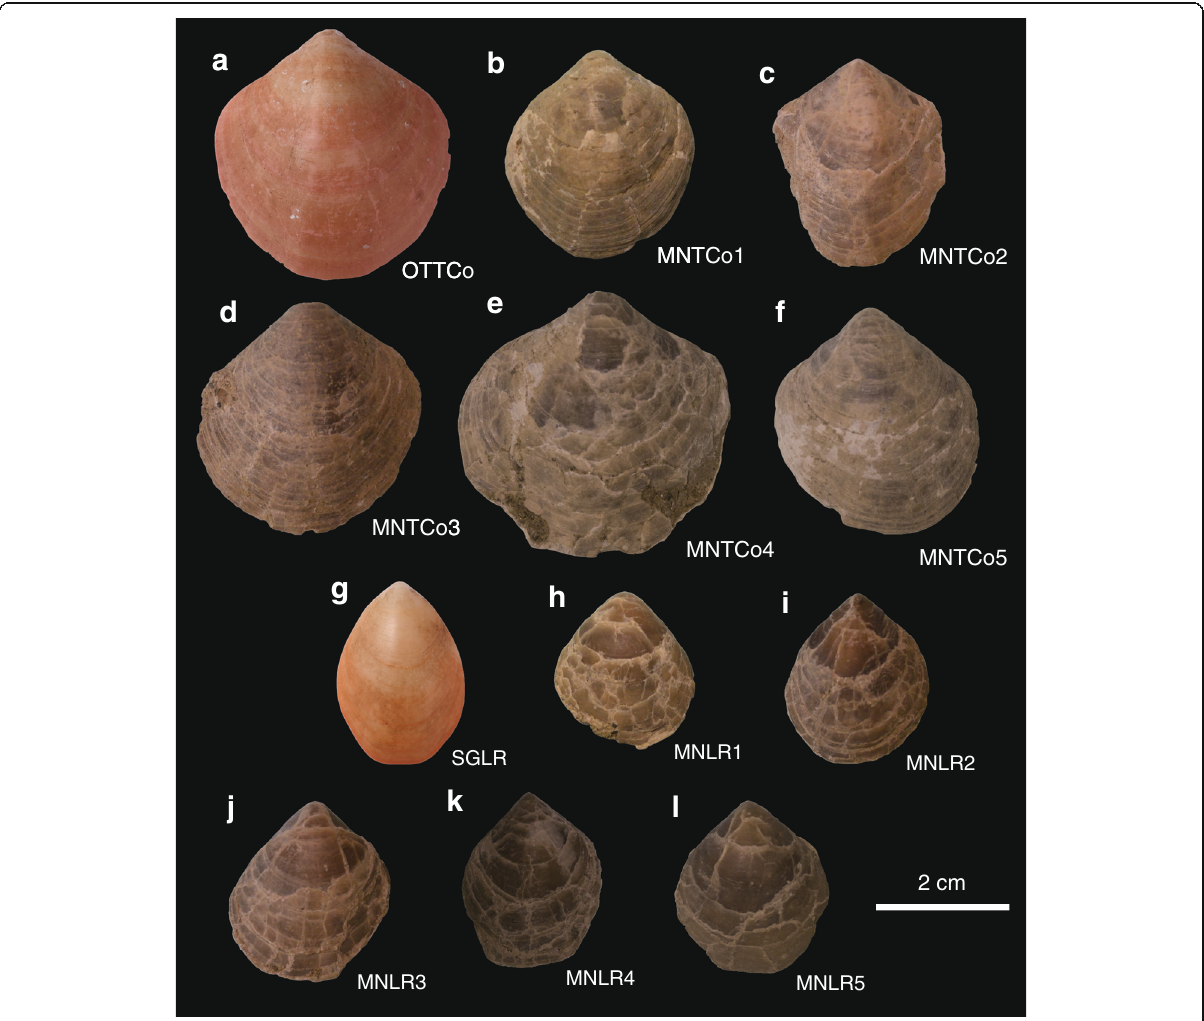
Fig. 1 Photographs of the Terebratalia coreanica and Laqueus rubellus shells examined in this study. The modern T. coreanica shells were collected from Otsuchi Bay, northeastern Japan, and L. rubellus shells were collected from Sagami Bay, central Japan. The fossil shells are from the Pliocene Tentokuji Formation in Minehama, northeastern Japan. a Modern T. coreanica . b – f Fossil T. coreanica . g Modern L. rubellus . h – l Fossil L. rubellus